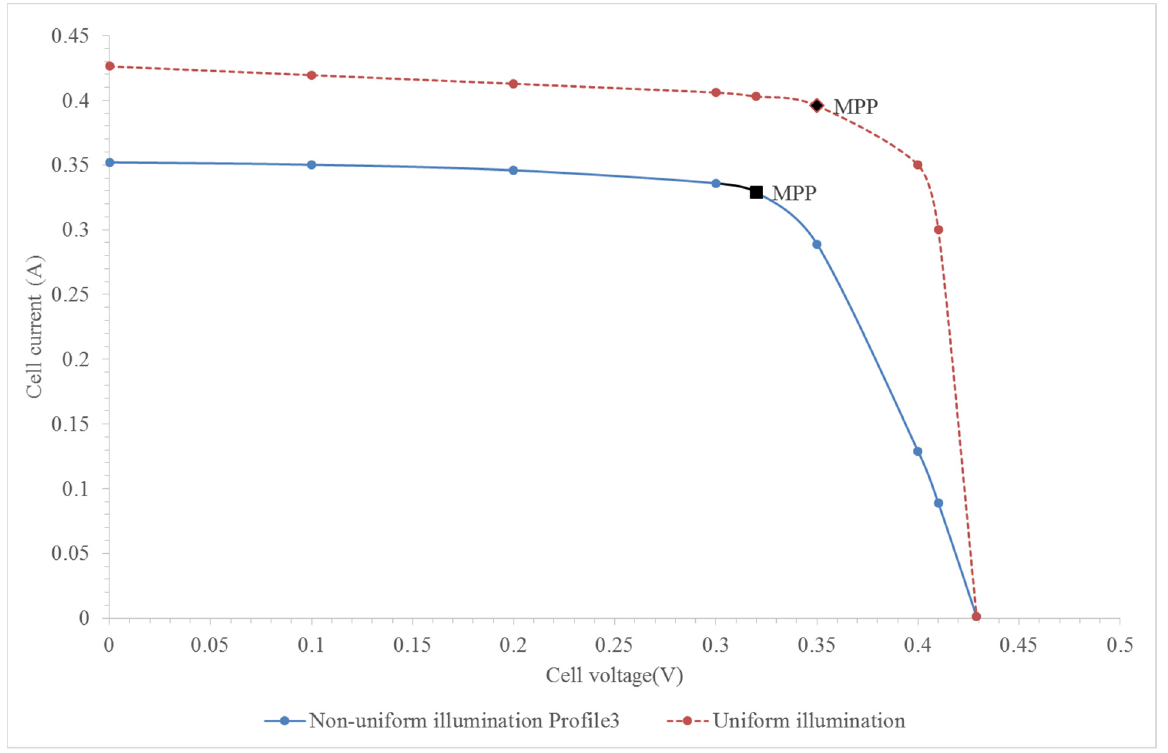
Figure 11. I-V curves for uniform illumination and illumination Profile